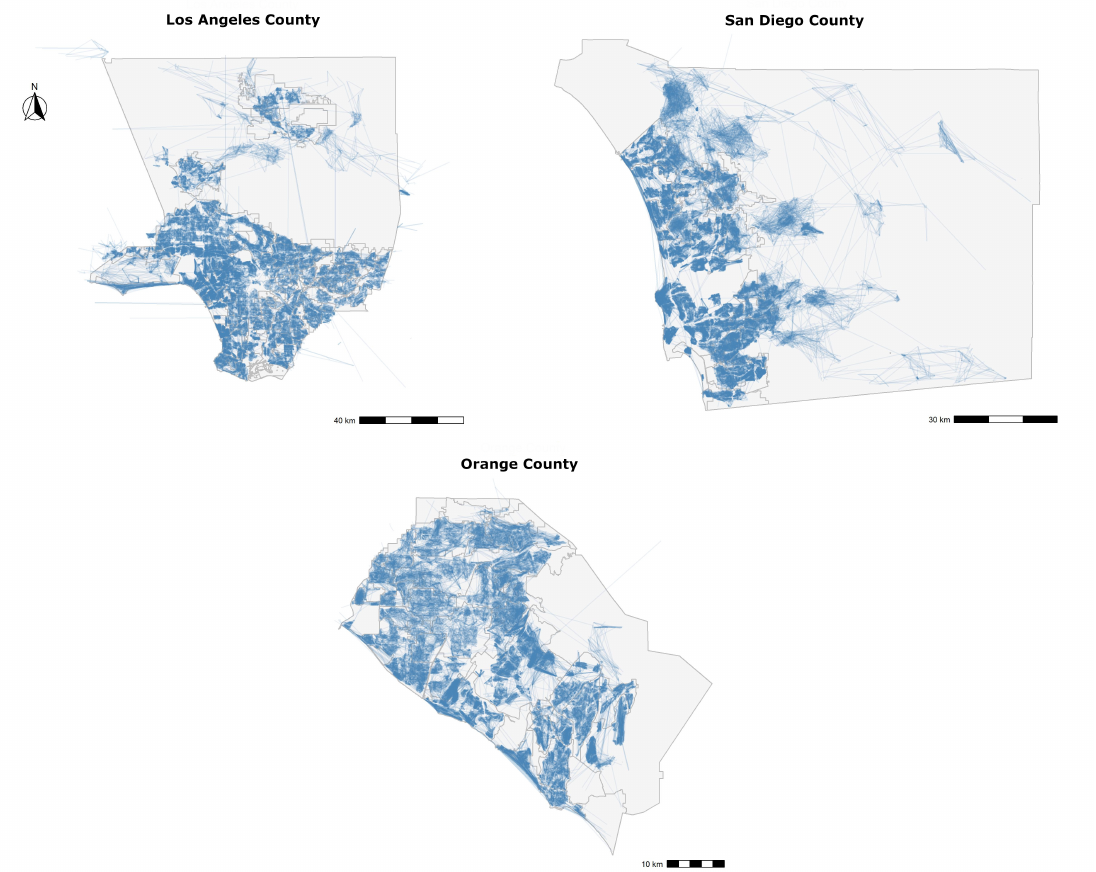
Figure 3. Network of links mapped between subjects and comparable properties in Southern California